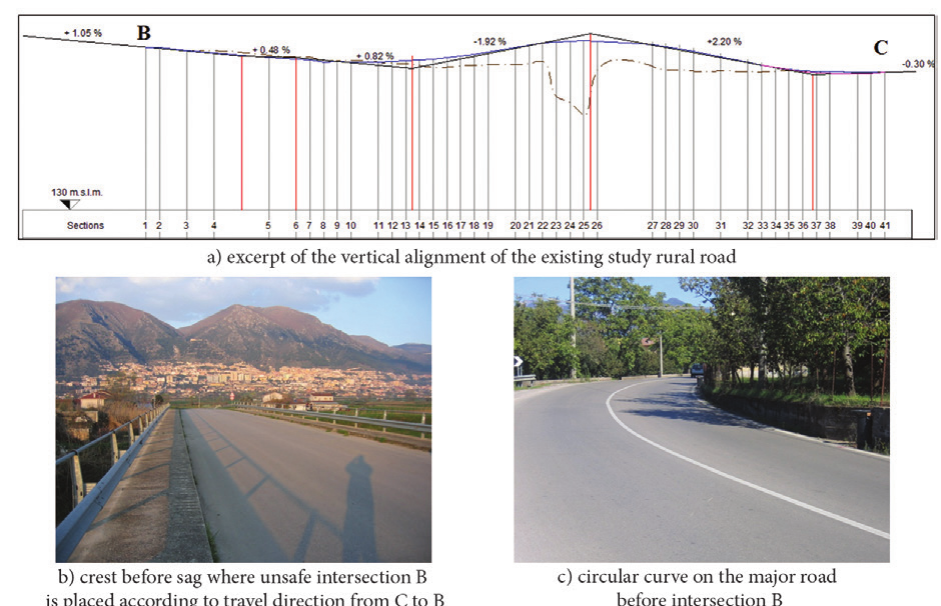
Fig. 2. Details about alignment of the investigated